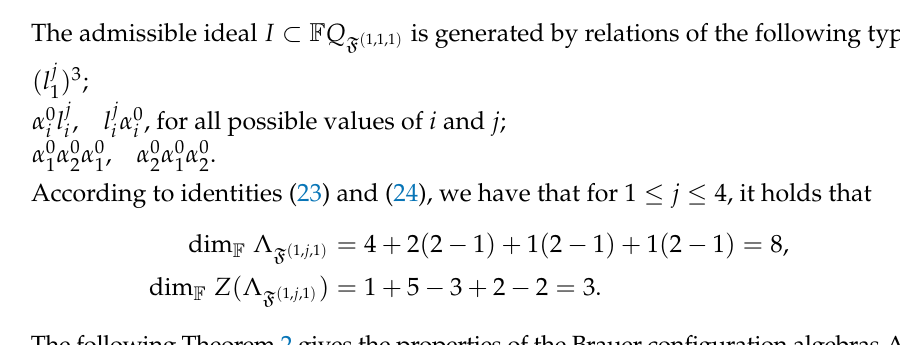
Figure 3. Brauer quiver induced by the Brauer configuration F ( 1,1,1 )